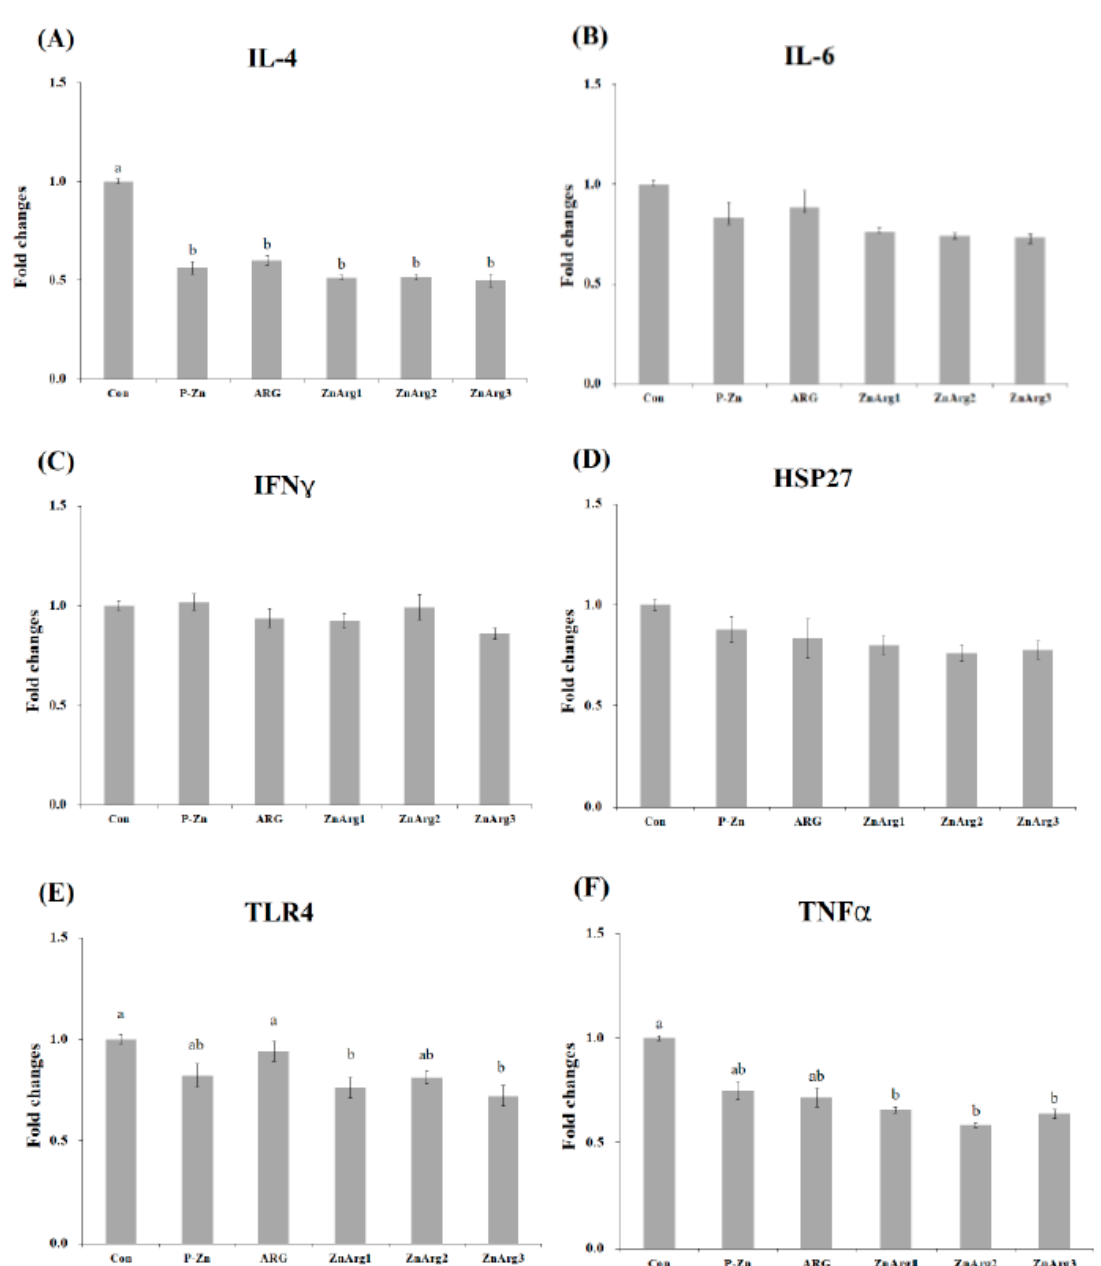
Figure 3. Relative expression of, ( A ) interleukin-4 (IL-4), ( B ) interleukin-6 (IL-6), ( C ) interferon- γ (IFN γ ), ( D ) heat shock protein-27 (HSP27), ( E ) toll like receptor-4 (TLR4), and ( F ) tumor necrosis factor- α (TNF- α ) in the liver of weanling piglets. Error bars represent standard error of means. Bars with different letters (a~d) differ significantly across all 6 treatment groups ( p < 0.05). Con: 1.1% Arg; P-ZnO: 1.1% Arg + 2500 mg Zn/kg diet; ARG: 1.6% Arg; ZnArg1: 1.6% Arg + 500 mg Zn/kg diet; ZnArg2: 1.6% Arg + 1000 mg Zn/kg diet; ZnArg3: 1.6% Arg + 2500 mg Zn/kg diet.